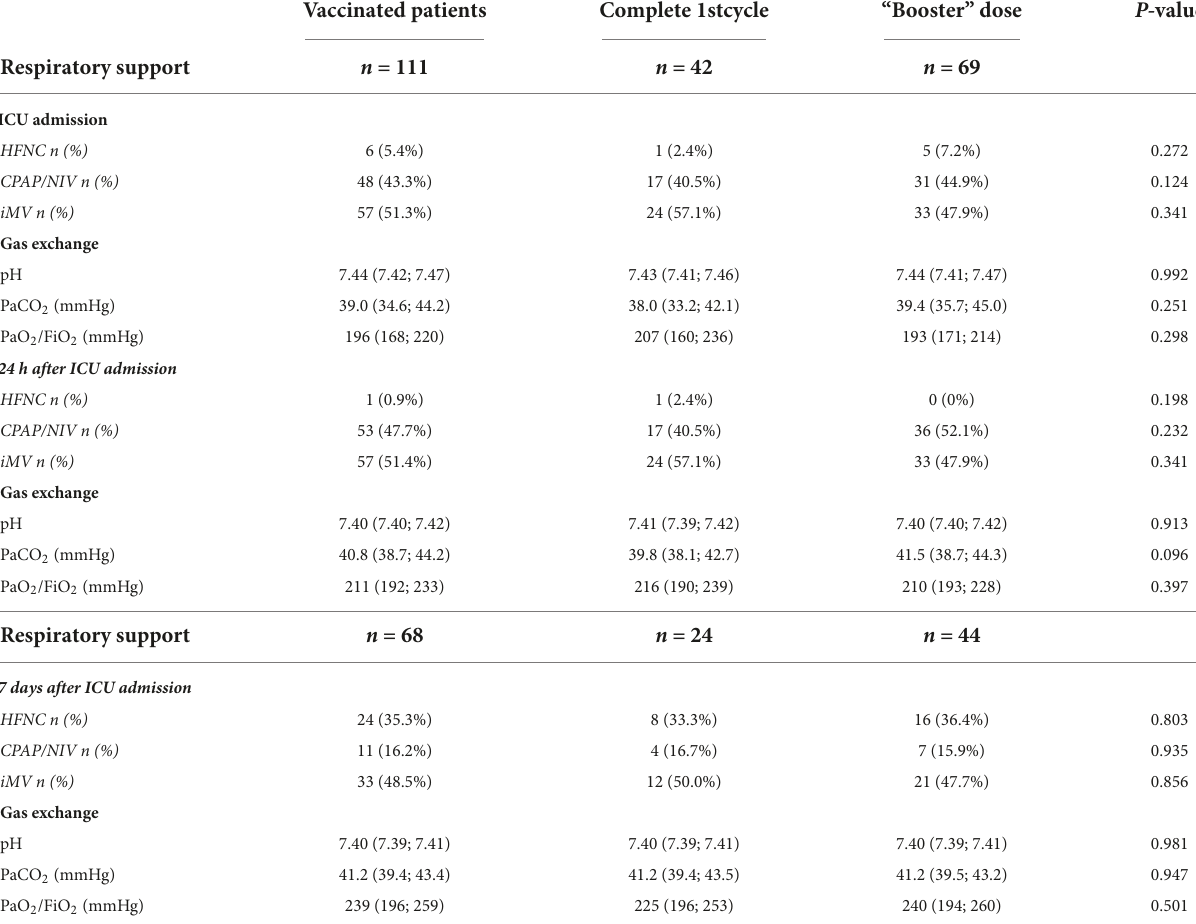
TABLE 4 Ventilatory support and gas exchange at Intensive Care Units (ICU) admission, 24 h and 7 days after between patients with first complete cycle of vaccination and “booster”